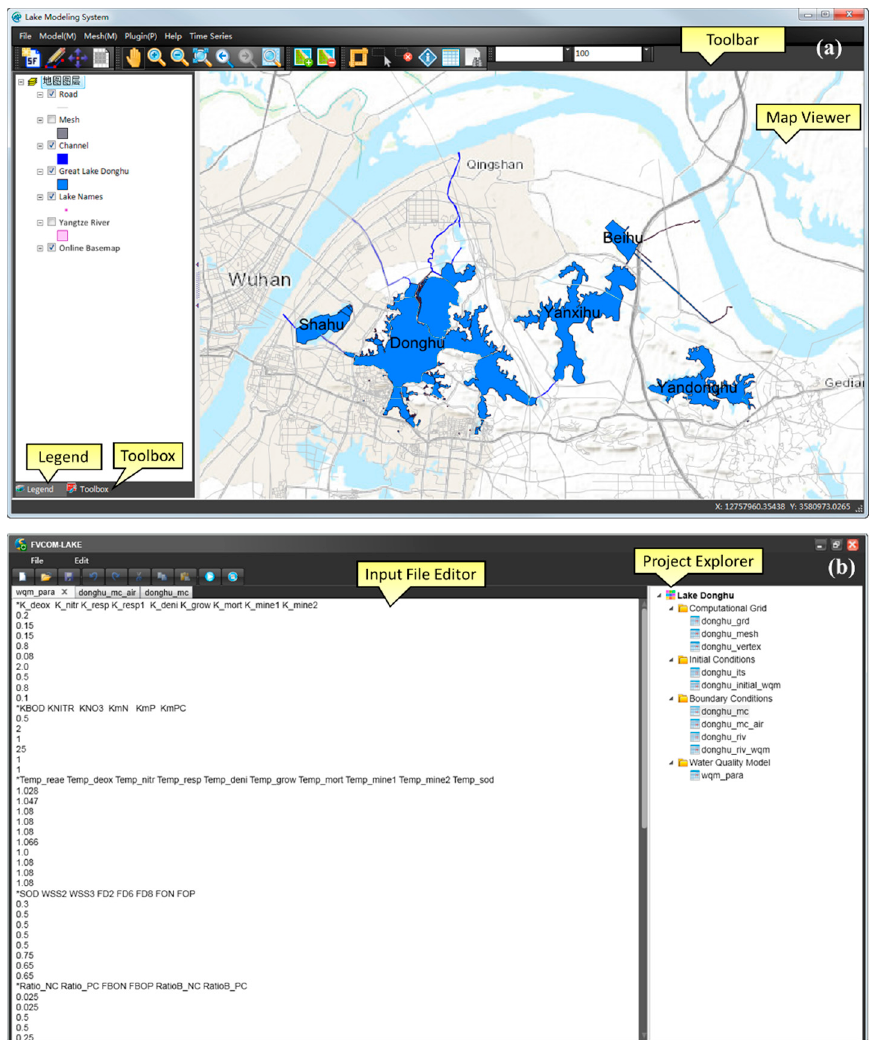
Figure 3. Main graphic user interface of LMS: ( a ) Map Viewer; and ( b ) Project Manager.